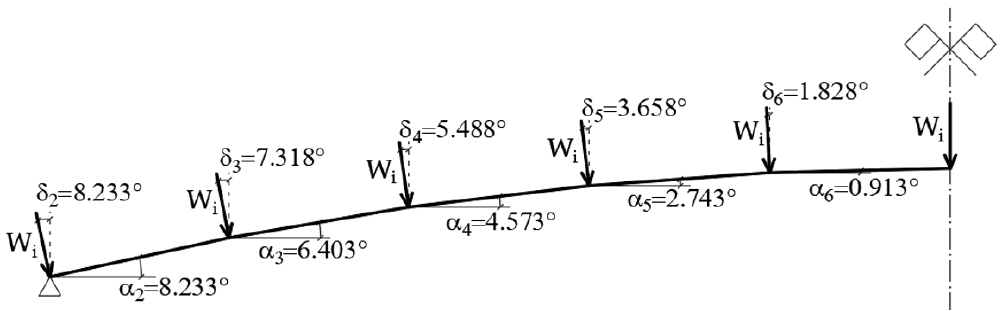
Figure 11. The values of angles α n and δ n.